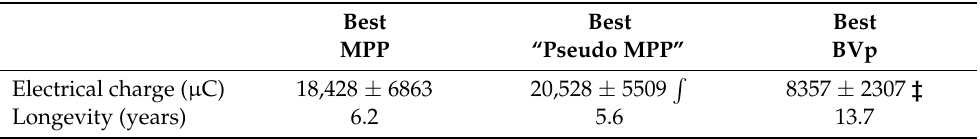
Table 3. Mean Electrical charge ( µ C) and theoretical longevity (years) at the threshold without safety margin. Best